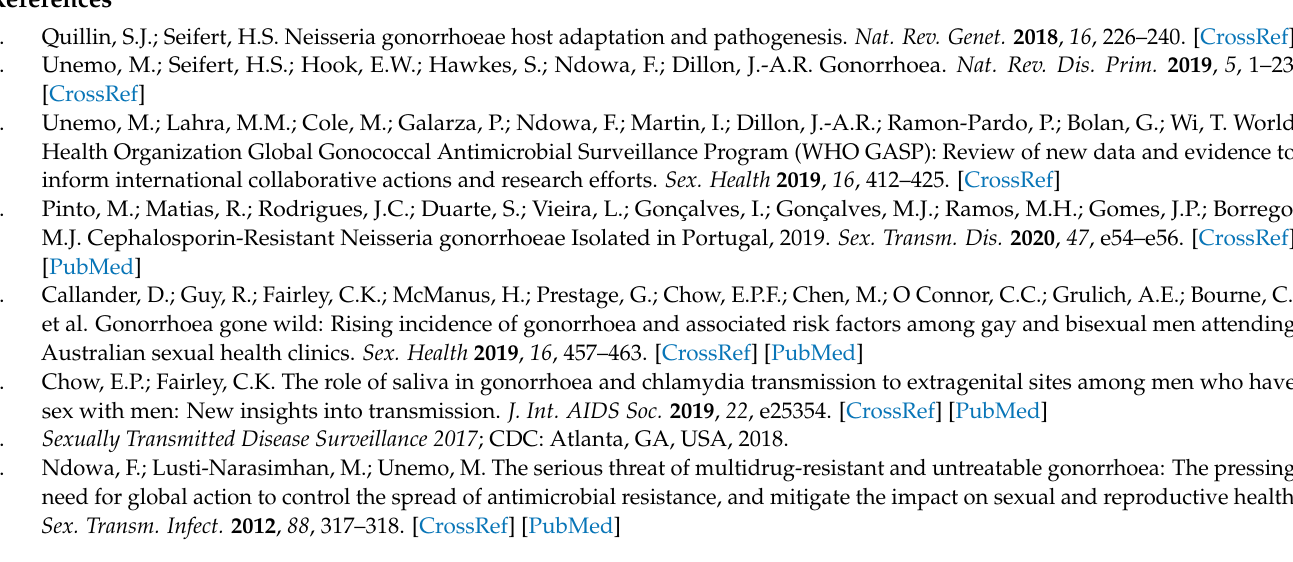
Figure S1: binding characteristics of maxibodies against a broad spectrum of N. gonorrhoeae , Figure S2: construction of N. gonorrhoeae multivalent maxibody, Figure S3: purification of N. gonorrhoeae multivalent